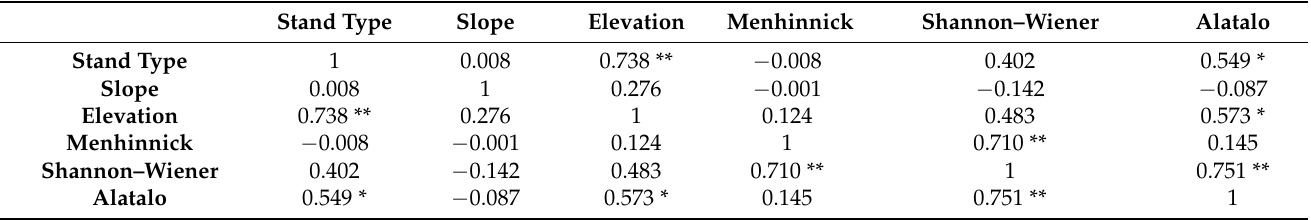
Table 2. Correlation analysis between topographic factors and vegetation factors.